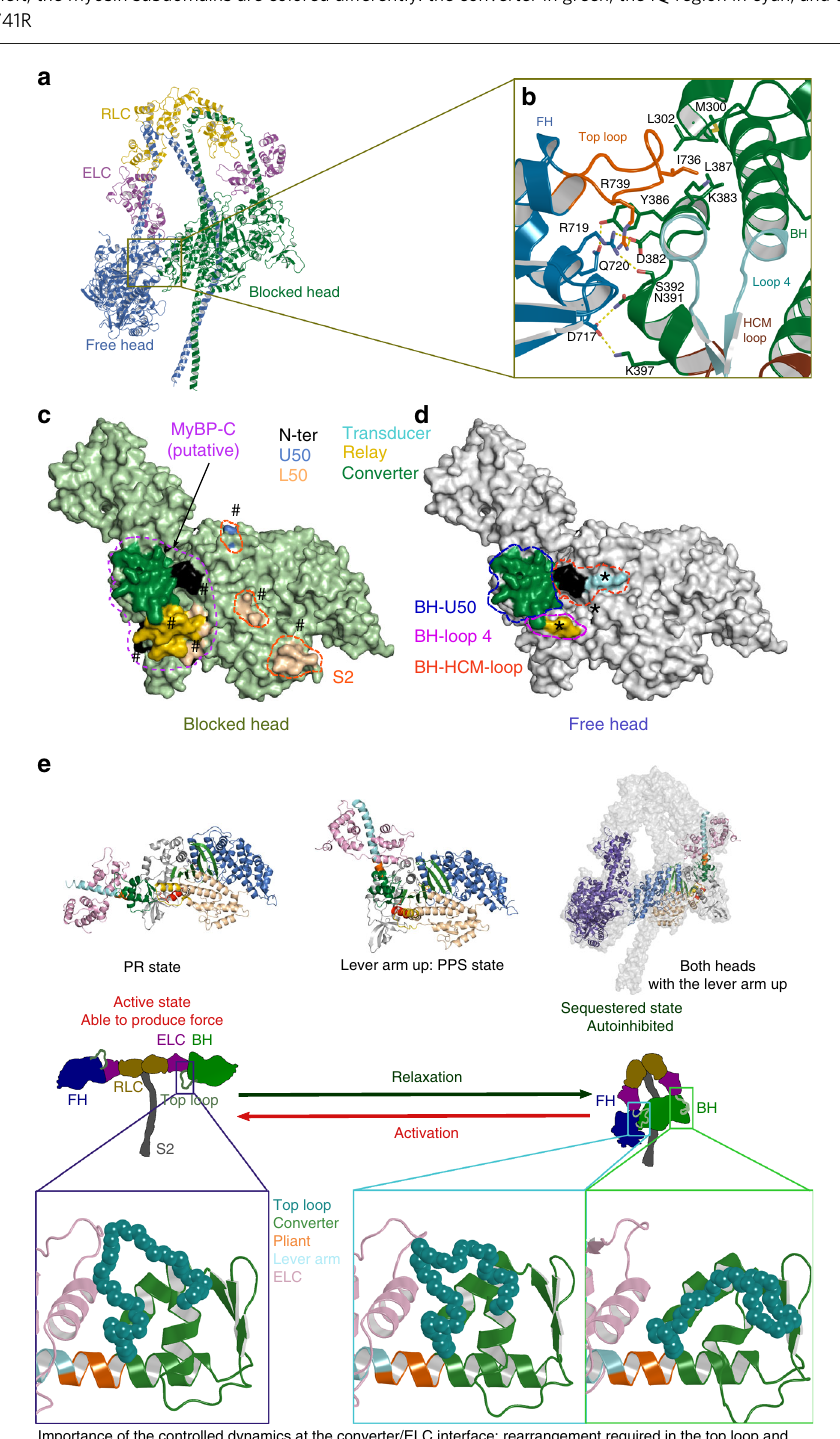
Fig. 3 Dynamics of the converter/ELC interface. Schematic representation of the results from the molecular dynamics simulations for the wild-type (WT) and the three HCM mutants that have been analyzed in silico: R719W, R723G, G741R. On the left, a “ putty representation ” of the β -cardiac myosin converter and fi rst IQ (aa 701 – 806) bound to the ELC. RMS fl uctuations during 30 ns simulations are represented with RMS. Scale ranging from 0.6 (in yellow) to 5.8 Å (in red). On the center, the structure of the interface between the ELC, the converter, and the pliant region is represented, as well as the position of key residues maintaining the interface and its plasticity. In each structure, the position of the residue mutated is labeled in red. On the right, a schematic representation of the region containing the converter, the ELC, and the lever arm is displayed. The different populations of the top loop allowed by the dynamics of this region are drawn and the nature of the interactions between the converter and the ELC is also represented. In each case a state is represented opaque and the others are in transparency in order to best compare the different populations (positions of the top loop are colored differently). On the center and on the left, the myosin subdomains are colored differently: the converter in green; the IQ region in cyan; and the ELC in light pink. a WT, b R719W, c R723G,